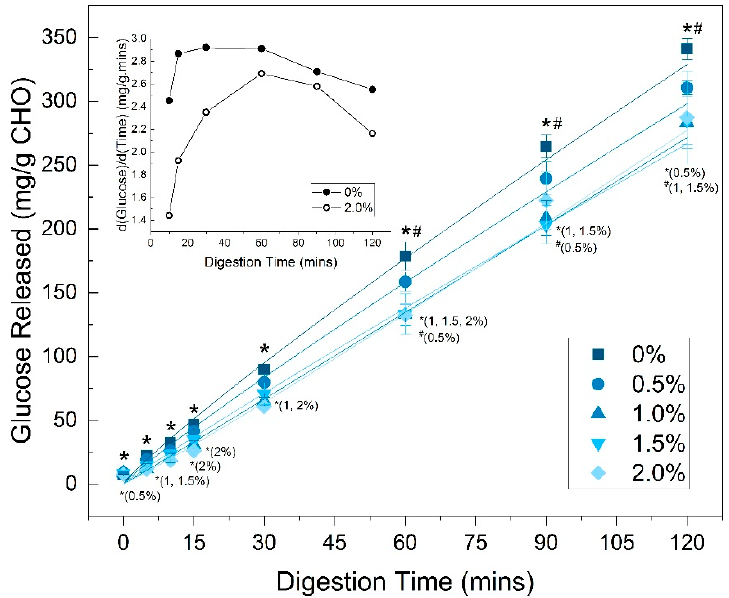
Figure 4. Glucose released (mg/g carbohydrate) in cooked noodles with 0%, 0.5%, 1.0%, 1.5% and 2.0% transglutaminase from 0 to 120 min of in vitro intestinal phase digestion; error bars represent S.D. based on duplicates; * represents significant difference from control at a time point ( p < 0.05), # represents trending difference from control at each time point ( p < 0.10); inset: first-order derivate (slope) of glucose release with digestion time (i.e., rate of glucose release) for noodles with 0% ( ) and 2.0% ( ) transglutaminase.